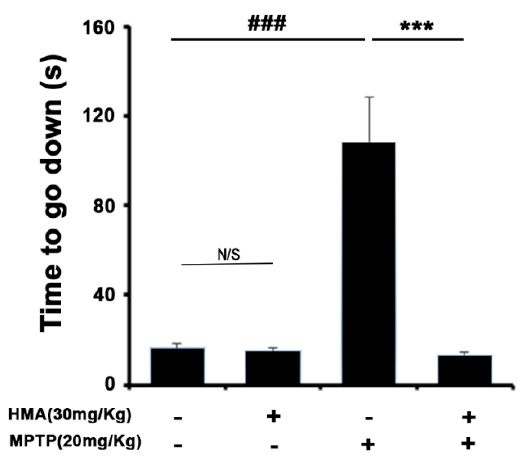
Figure 5. Effect of HMA on the behavioral deficit in 1-methyl-4-phenyl-1,2,3,6-tetrahydropyridine (MPTP)-intoxicated mouse. Thirty mg / kg, p.o. (HMA) was dosed for 15 days before MPTP administration (20 mg / kg, 4 injections / day, 2 h interval, i.p.). Values are mean ± S.E.M, n = 12.